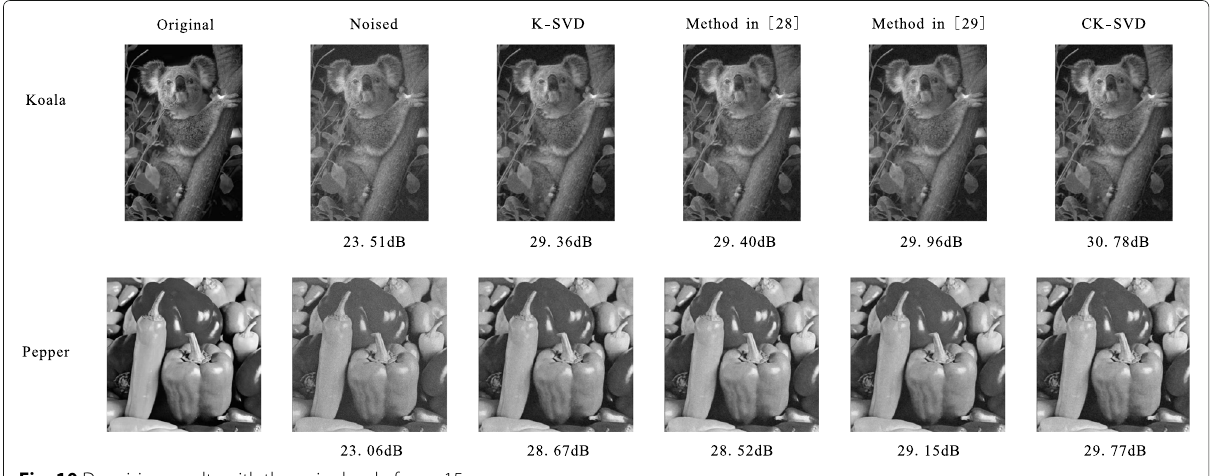
Fig. 10 Denoising results with the noise level of σ = 15